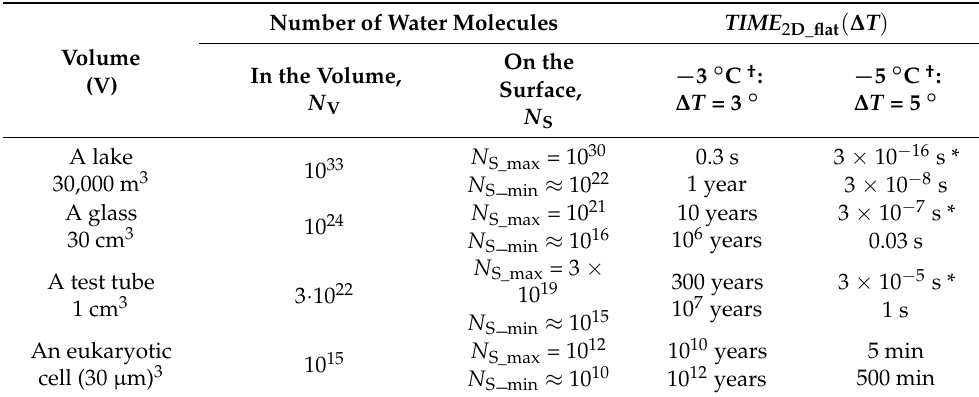
Table 2. Time of heterogeneous ice nucleation on flat and smooth ice-binding